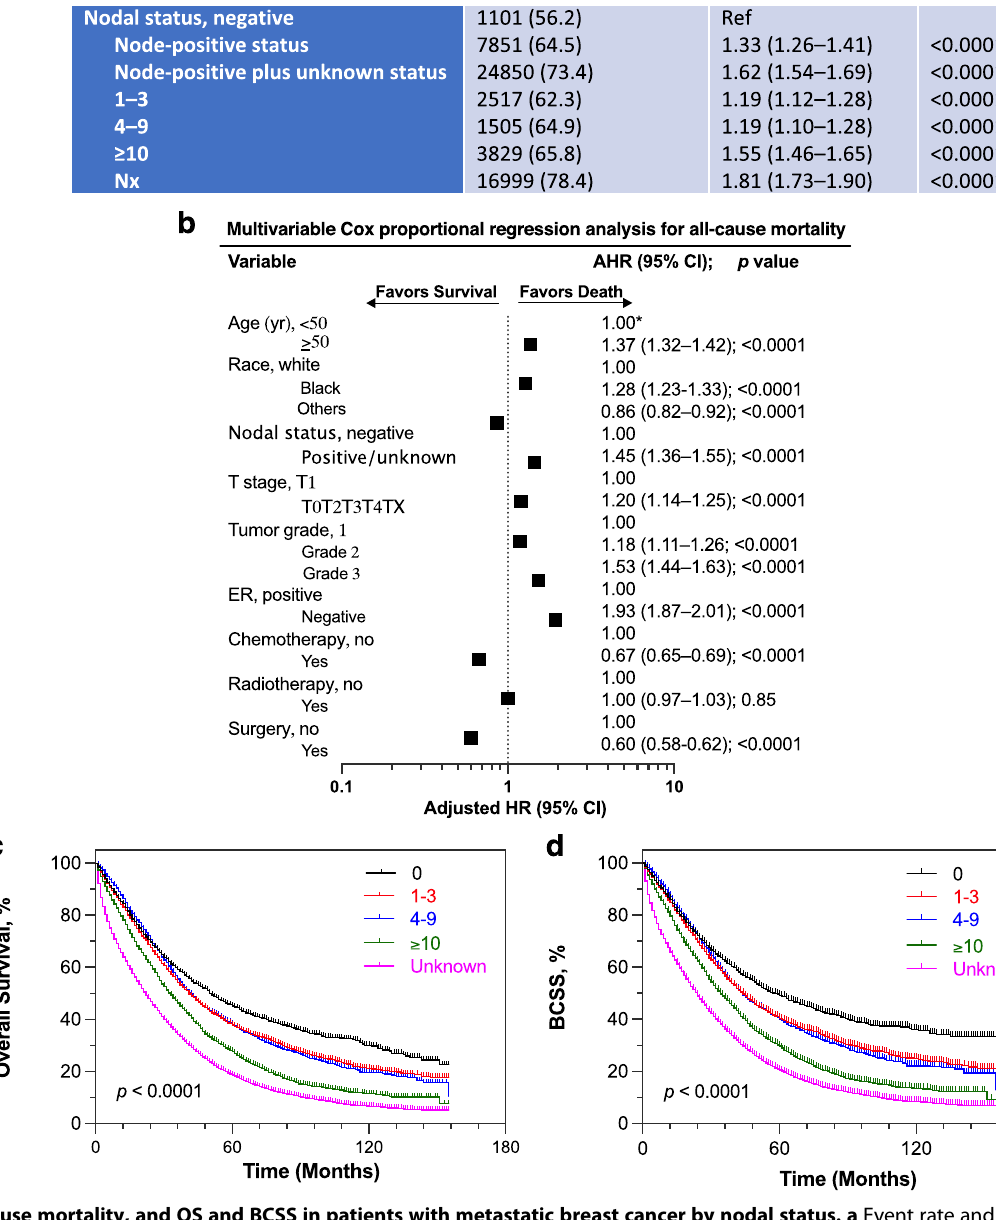
Fig. 2 All-cause mortality, and OS and BCSS in patients with metastatic breast cancer by nodal status. a Event rate and risk of mortality by nodal status at univariate level. HR and 95% CI of ratio were computed by Cochran-Mantel-Haenszel test. HR, hazard ratio; Ref, reference population. b Multivariable Cox model and all covariates in association with the number of death events in the Cox model were analyzed by likelihood ratio test and shown in the forest plot; data were presented as adjusted HR (AHR) with 95% CI. *1.00, reference group. AHR of 1.00 indicates a lack of association; greater than 1.00, an increased risk of mortality; and less than 1.00, a decreased risk of mortality in the forest plot. ER, estrogen receptor. c Kaplan – Meier analysis of OS and d of BCSS strati fi ed by node-negative, 1 – 3, 4 – 9, 10 nodes or greater involvements, and node unknown